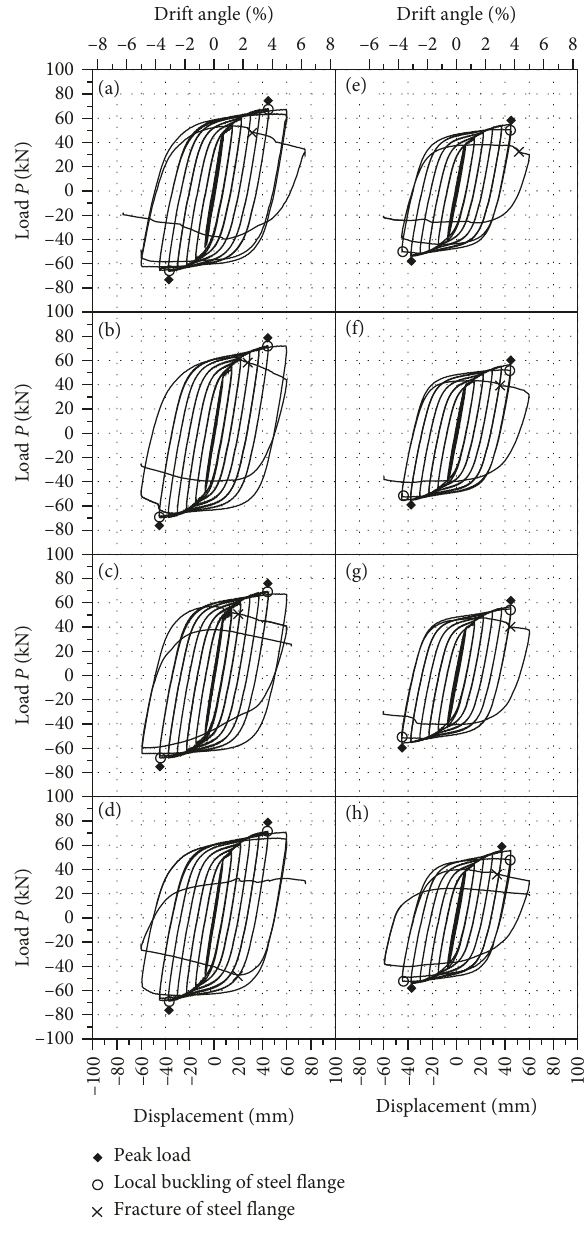
Figure 12: Load versus displacement hysteresis loops. (a) PS-NB. (b) PS-SC. (c) PS-MS. (d) PS-HS. (e) PW-NB. (f) PW-SC. (g) PW-MS. (h) PW-HS.